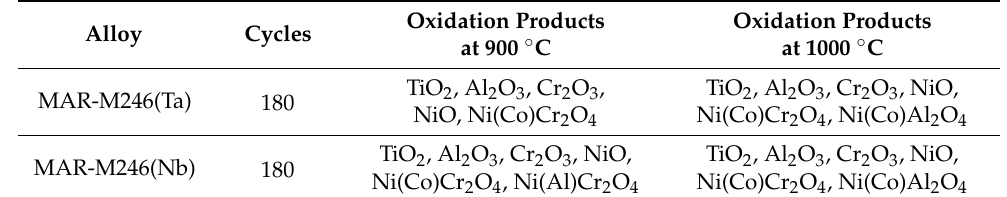
Table 2. Oxidation products obtained by XRD diffractograms for 180 cycles.